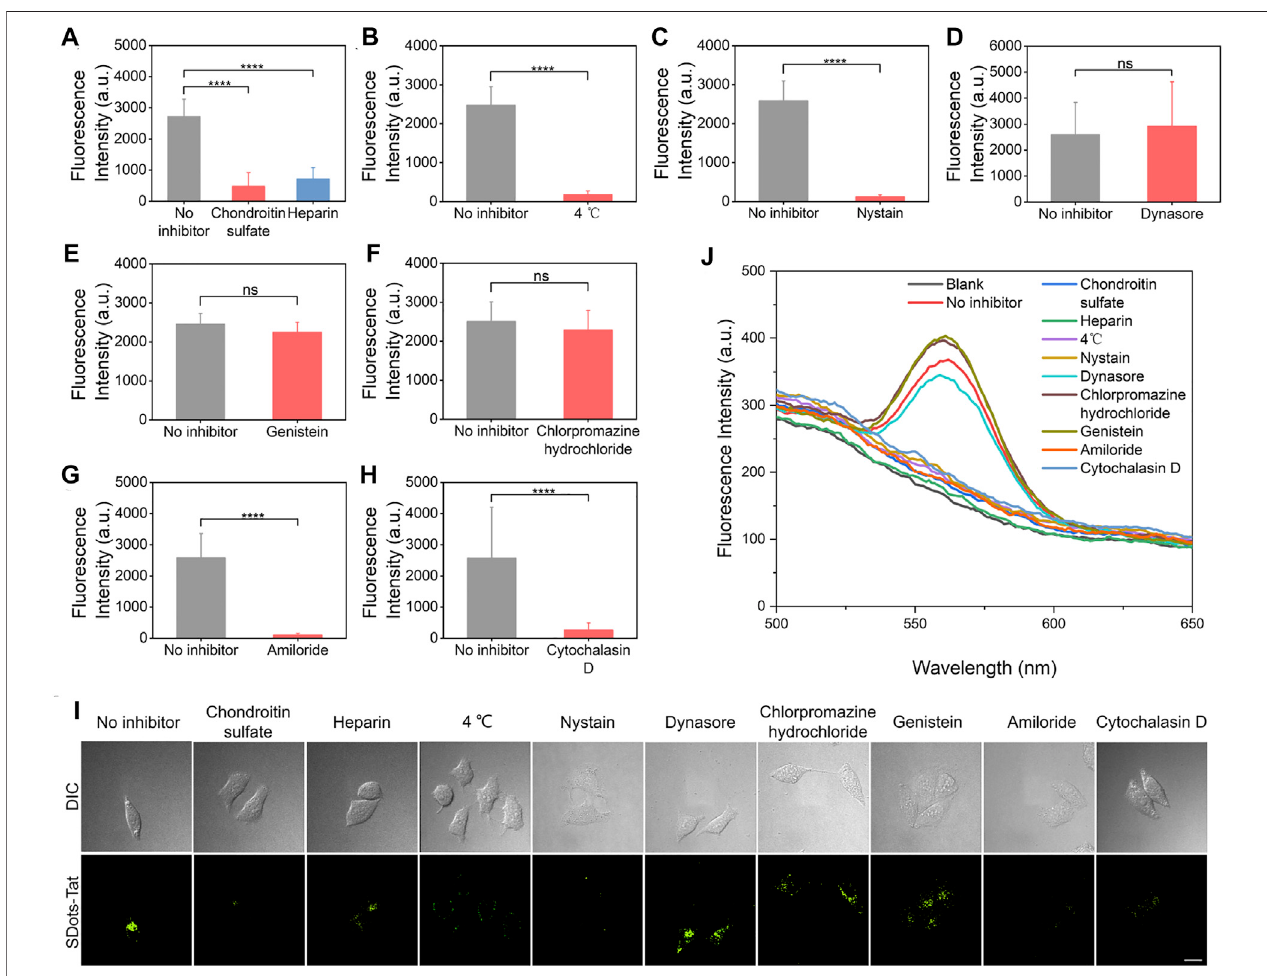
FIGURE 1 | Inhibitor studies of the cellular entry process of SDots-Tat. (A – H) Quanti fi cation results based on live-cell fl uorescent microscopy. Error bars, mean ± s.e.m, n > 50. ***, p < 0.001;ns, notsigni fi cant(Student ’ st-test).The cells werepretreatedwith inhibitors for30 min and werethen incubated with SDots-Tat for 30 min. (A) Inhibitorsforproteoglycans;chondroitinsulfate,50 μ g/ml;heparin,25 μ g/ml. (B) Low-temperatureinhibitionofendocytosis. (C) Inhibitorforlipidraft,nystatin,25 μ g/ ml. (D) Inhibitor for dynamin, dynasore, 10 μ M. (E) Inhibitor of clathrin-mediated endocytosis, chlorpromazine hydrochloride, 100 μ g/ml. (F) Inhibitor for caveolae- mediated endocytosis, genistein, 17.5 μ g/ml. (G) Inhibitor of macropinocytosis, amiloride, 100 μ M. (H) Inhibitor of F-actin, cytochalasin D, 2 μ M. (I) Corresponding representativeconfocal fl uorescentmicroscopyimages.Scalebar,20 μ m. (J) Resultsofinhibitorstudiesanalyzedbyanalternativemethod:thecellswereremovedfrom thecellcultureplates2 hafterincubatingSDots-Tatwiththecells(thecellswerepretreatedwiththeinhibitorsfor30 min).Theincubationtimewiththecellswasselected tobalancetwoconsiderations:1)iftheincubationtimewastooshort,wewouldnotbeabletodetectsigni fi cantcellularuptakeamountforallsamples;2)iftheincubation timewastoolong,thecellscoulddevelopwaystorecoverfromtheinhibitor effectssothatwewouldnotbeabletodistinguish thedifferences incellular uptake between different samples. Subsequently, 5 × 10 6 cells were broken by probe sonication, and fl uorescent spectroscopy was used to analyze the quantity of SDots-Tat uptake. “ Blank ” refers to the result with no SDots-Tat being incubated with the